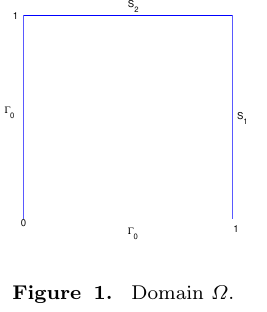
Figure 1. Domain Ω